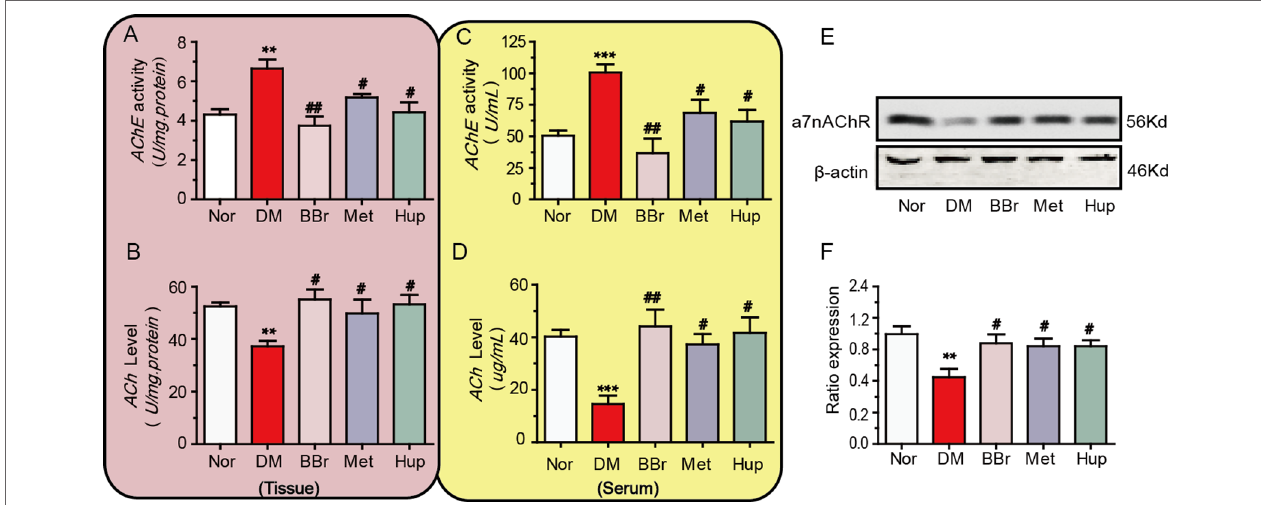
FIGURE 4 | Berberine ameliorates the cholinergic signaling pathway dysfunction. (A , B) The AChE activity and ACh levels in diabetic rat’s periphery, n = 8–12. (C , D) The AChE activity and ACh levels in diabetic rat’s hippocampus, n = 8–12. (E , F) The a7nAChR expression in diabetic rat’s hippocampus was detected by Western-blot and quantified by image J, n = 3. ** P < 0.01 vs. Nor; *** P < 0.001 vs. Nor; # P < 0.05 vs. DM; ## P < 0.01 vs. DM.